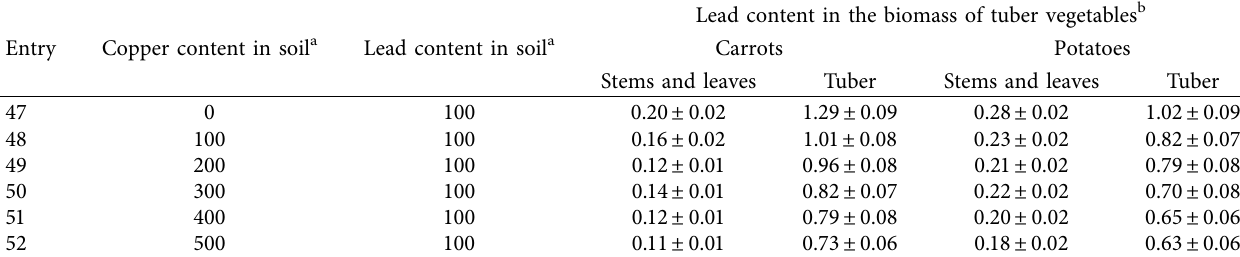
Table 8: Effect of copper on the accumulation of lead from soil to tuber